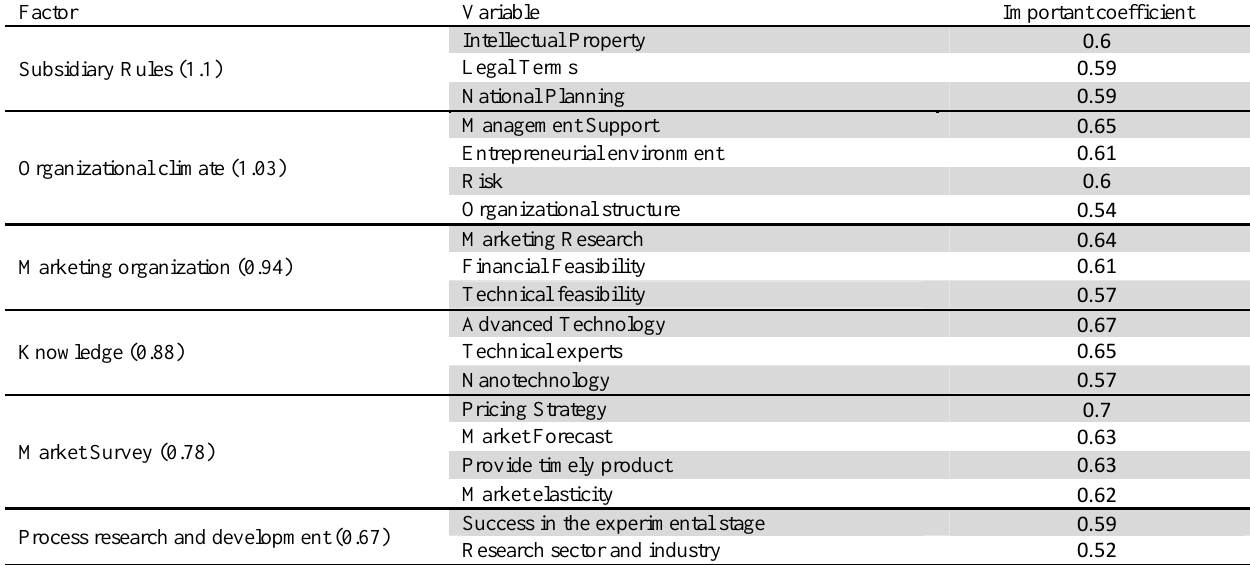
The summary of six factors and their